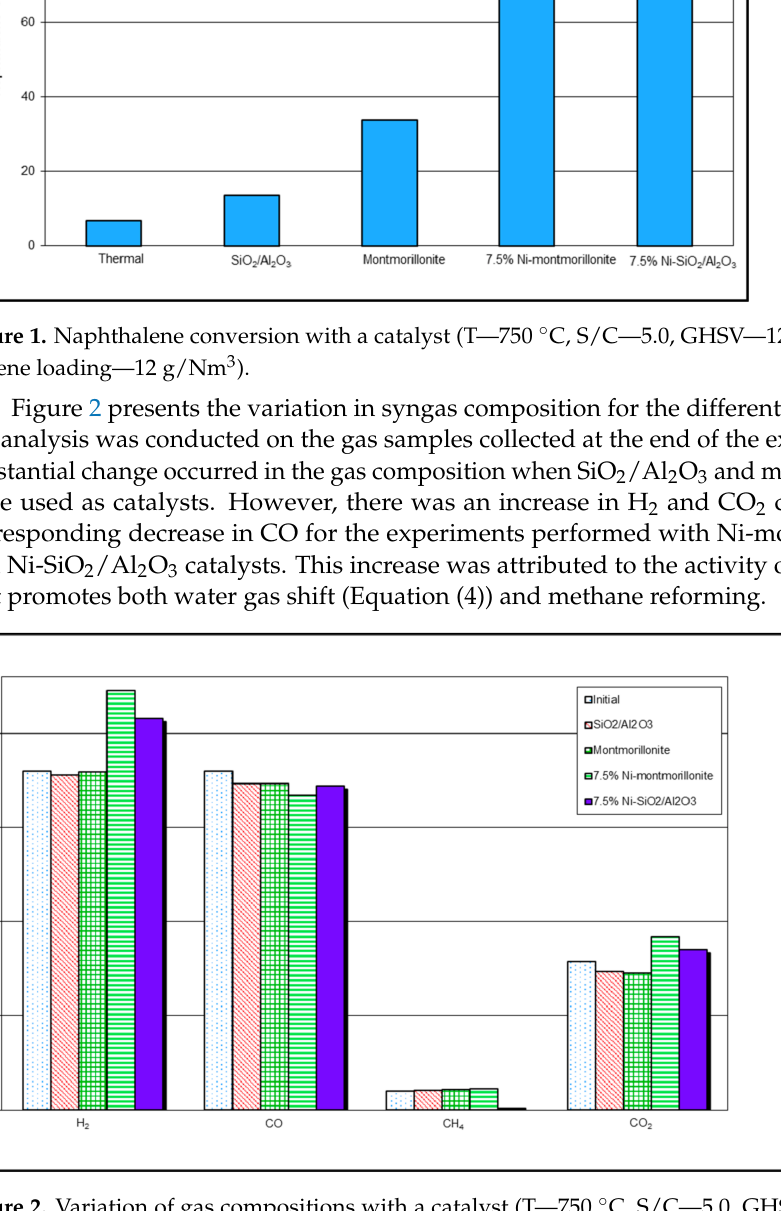
Figure 2. Variation of gas compositions with a catalyst (T—750 ◦ C, S/C—5.0, GHSV—12,800 h − 1 , naphthalene loading—12 g/Nm 3